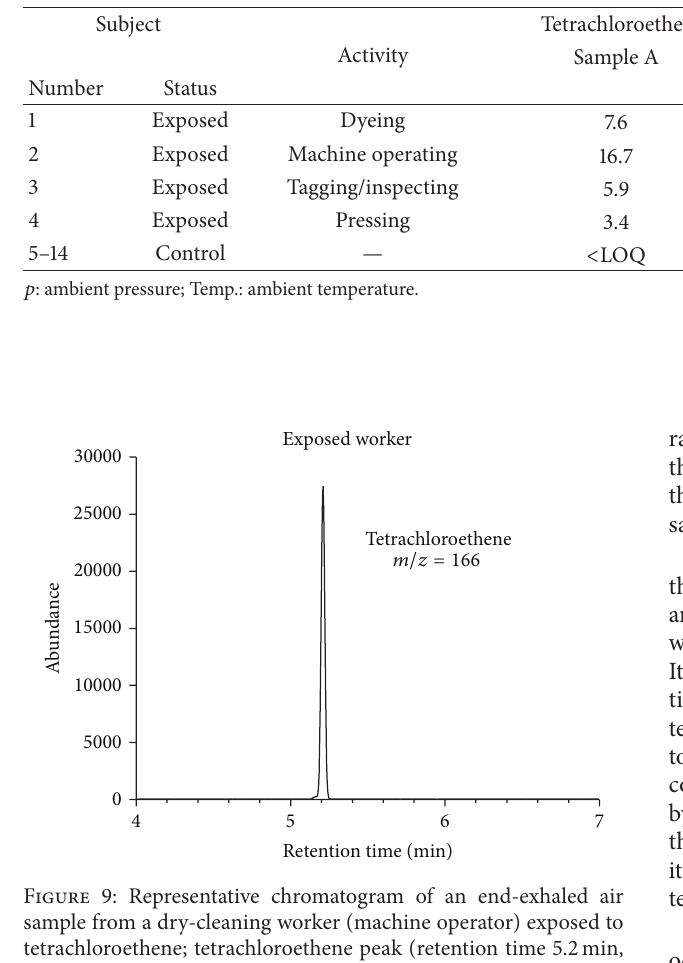
Table 3: Measurement results of the field study: tetrachloroethene in end-exhaled air in exposed (dry-cleaning workers) and nonexposed (control group) subjects.